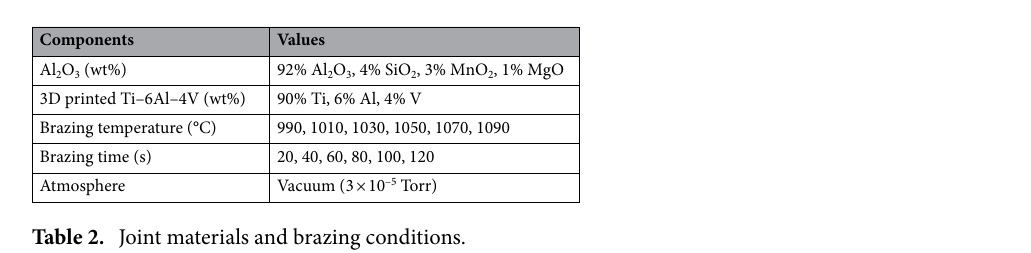
Figure 1. Microstructures of joint materials; ( a ) Al 2 O 3 (92%) and ( b ) Ti–6Al–4V (3D printed), and ( c ) schematic of joint components.